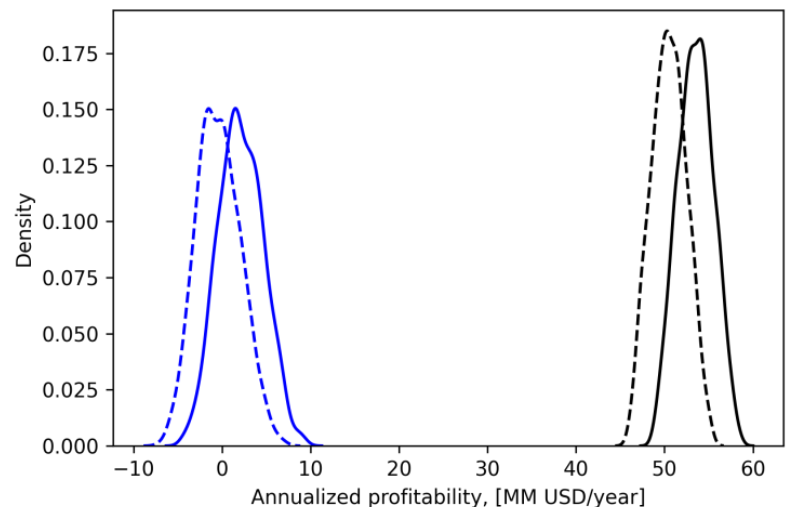
Figure 5. Distributions of the annualized profitability. Blue distributions correspond to sodium thiosulfate, and black distributions correspond to sodium cyanide. The dashed lines are the systems that did not include Hg treatment. The continuous lines are the systems that included Hg treatment.